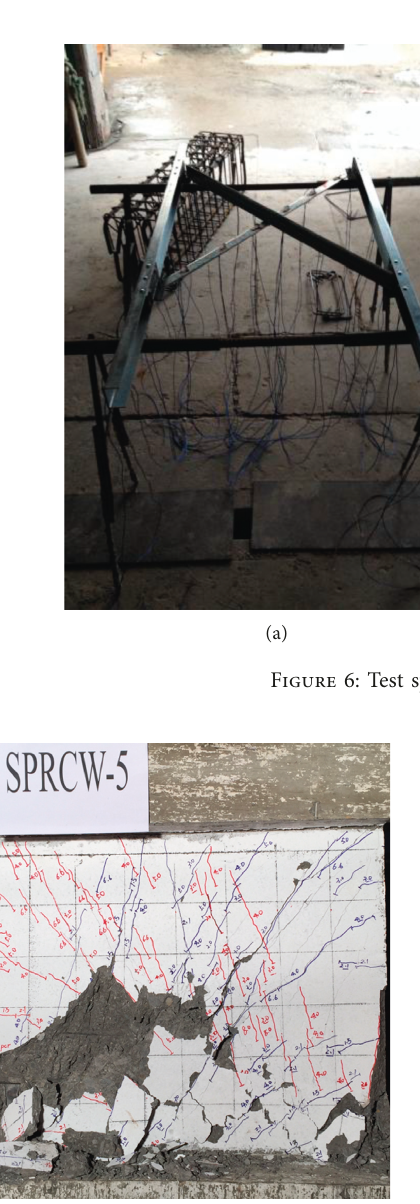
Figure 7: Failure mode of SPRCW-5.